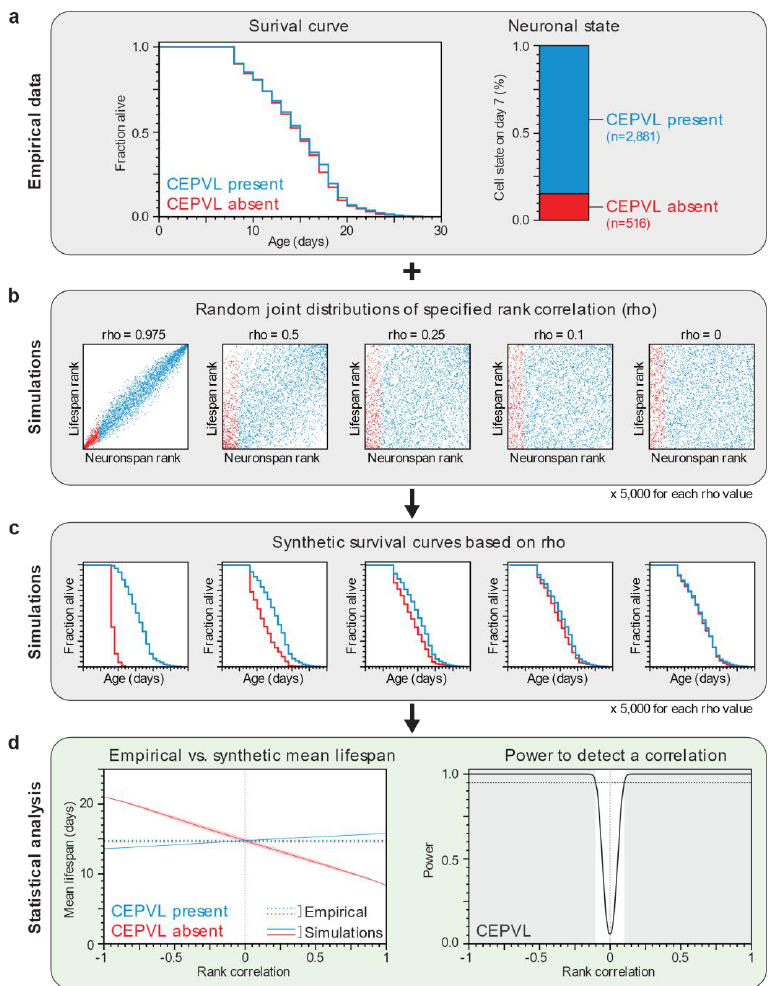
Figure 3. Statistical analysis strategy based on empirical data and computational simulations. ( a ) This panel shows the two types of data that we collected for each individual expressing α-synuclein in dopaminergic neurons: its lifespan and the state of each of its four cephalic neurons on day 7 of adulthood. These data were used to construct the empirical distribution of lifespan (plotted as a survival curve) and neuronal state; ( b ) We generated collections of random joint distributions of varying Spearman rank correlation values. Each point represents a simulated animal that has a relative lifespan and neuronspan. Simulated animals where a neuron is absent on day 7 have the lowest neuronspans (red points), while those were a neuron was present have the highest neuronspans (blue points). The joint distribution size equals the number of individuals in the empirical data set and the proportion of points labelled as “present” or “absent” equals the observed proportion of neuronal states; ( c ) We generated synthetic survival curves by dividing the empirical lifespans based on their rank, using the simulated lifespan ranks of the present (blue) and absent (red) groups in each random joint distribution; ( d ) The collection of synthetic survival curves was analyzed statistically to model how the mean lifespan of each group varies with Spearman rank correlation value. The shaded areas represent the 95% point-wise confidence interval of the mean lifespans of the synthetic curves. The statistical power of our experiment is the fraction of simulations with a statistically significant ( p < 0.05) difference in survival between the neuron present and absent groups. The shaded region denotes the Spearman’s rank correlation values where statistical power is greater than 95% (dotted line). The empirical data and statistical analysis shown in this figure is also shown in Figure